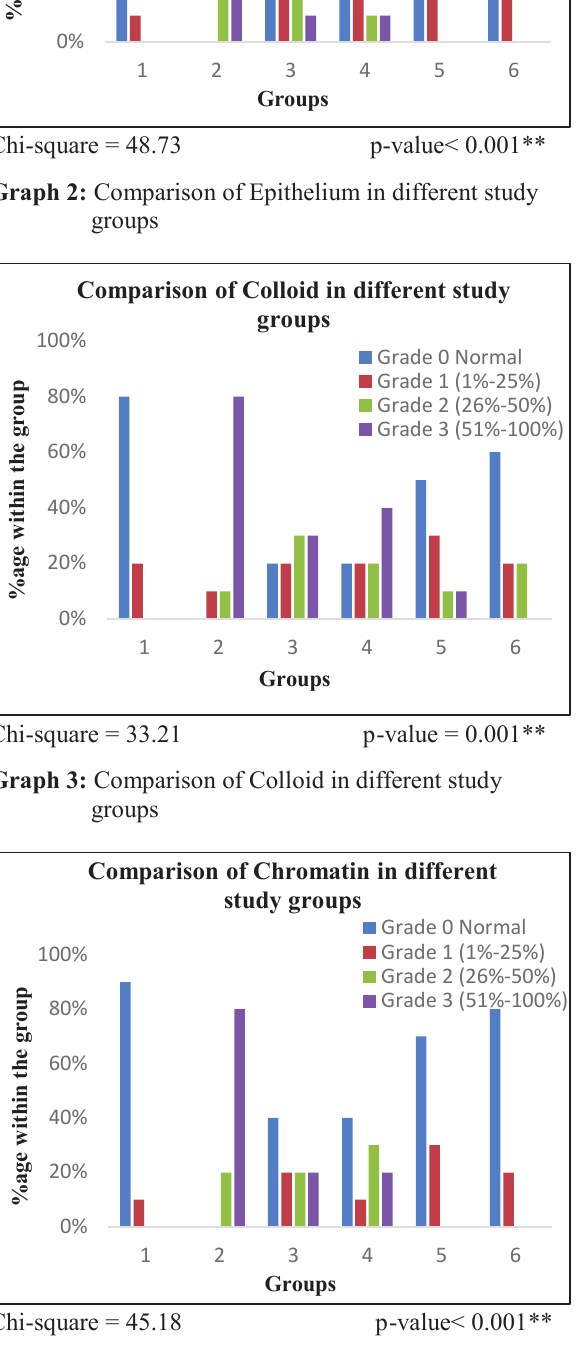
Graph 4: Comparison of Chromatin in different study